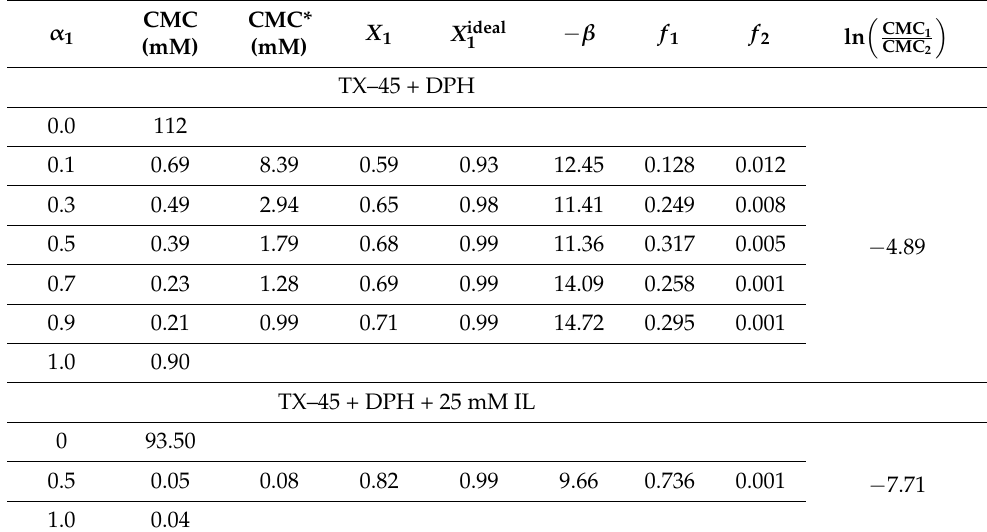
Table 1. Micellar parameters of TX–45 and DPH mixtures in the attendance and non-attendance of 25 mM IL at T = 298.15 K